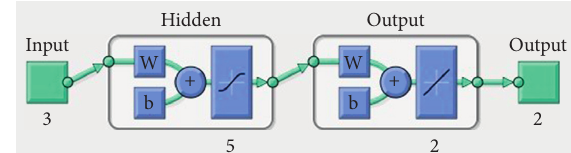
Figure 8: Optimum ANN architecture.